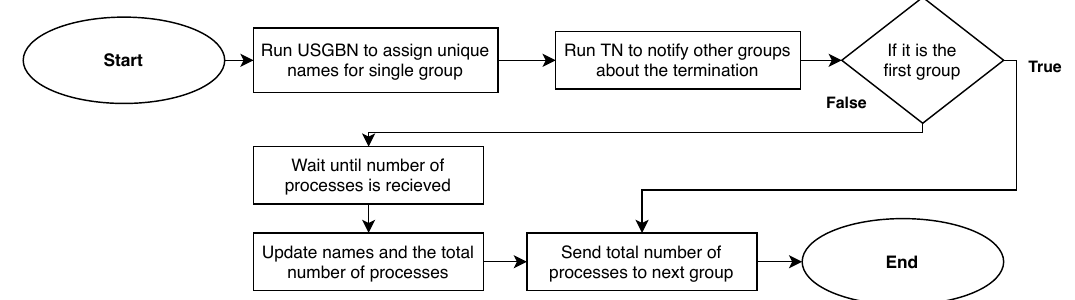
Figure 4. Flow chart of the two parts in the UMCBN